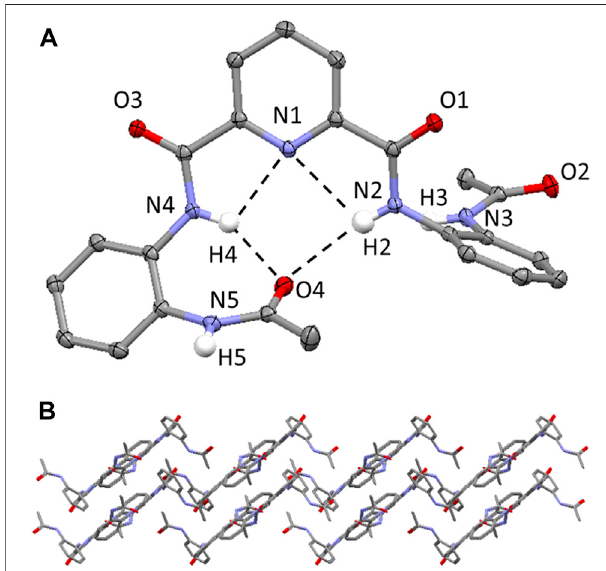
FIGURE2|(A) Molecular structure of compound 1 . H atoms (expect those on the N atoms of the amide bonds) have been omitted for clarity and displacement ellipsoids are at 50% probability level. The hydrogen bonding interactions are shown as dashed black lines. H atoms are shown in white, C atoms in grey, N in light blue, O in red. (B) Crystal packing of 1 highlighting the slipped stacked layered arrangement aligned along the b axis. Hydrogen atoms have been omitted for clarity.